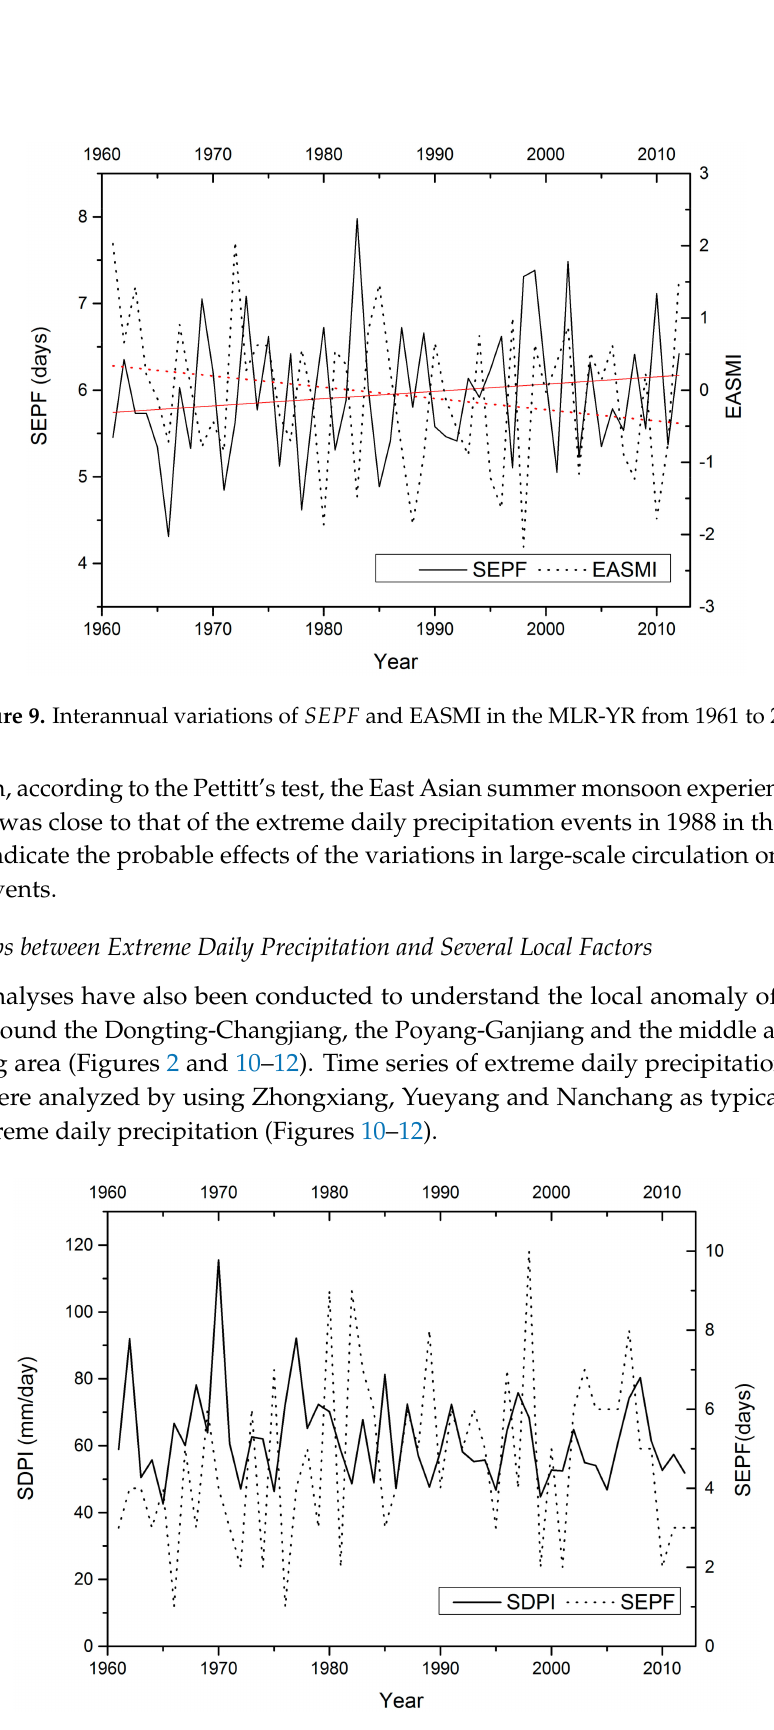
Figure 10. Interannual variations of SDPI and SEPF at the Zhongxiang station in the low reach of Hanjiang River from 1961 to